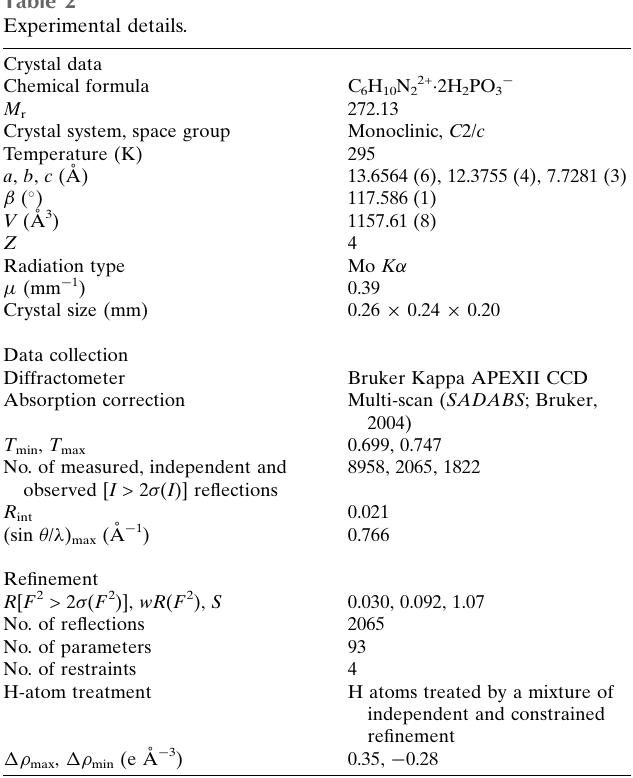
Table 2 Experimental details.